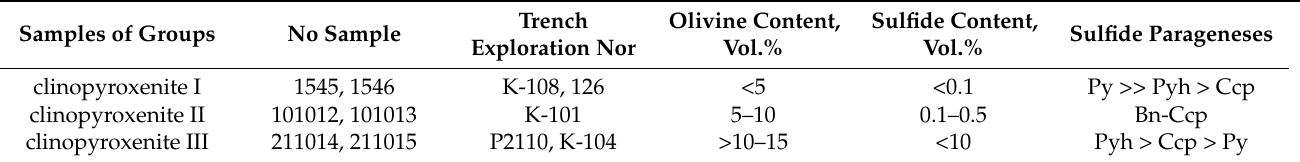
Table 1. Features of studied clinopyroxenite samples from Ozernoe